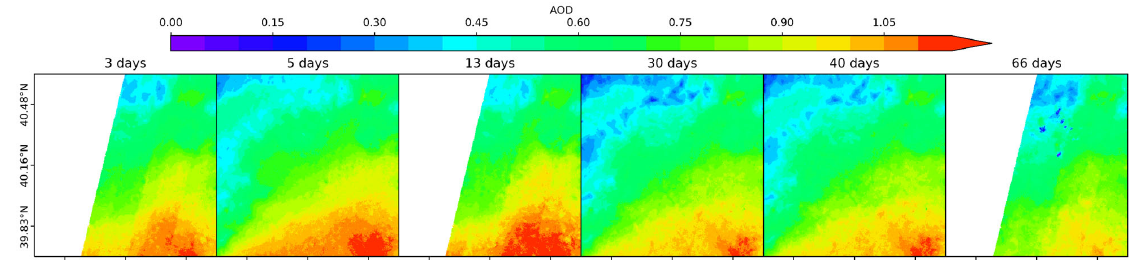
Figure 6. The number distribution map of inliers in a retrieval window. AOD distribution map that is not interpolated and AOD distribution map that is interpolated in two regions (UTC).